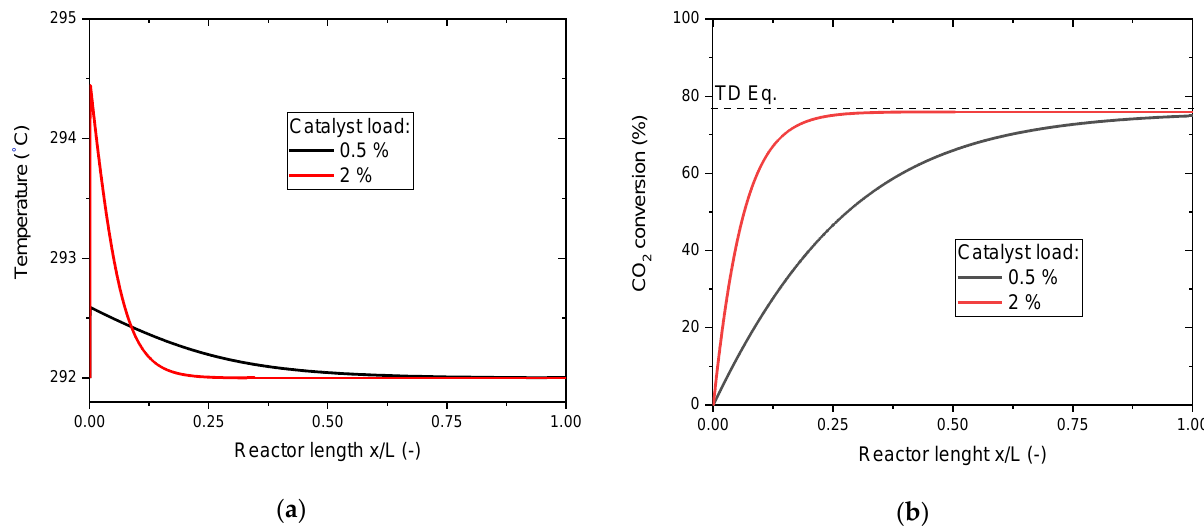
Figure 6. The predicted ( a ) temperature profile and ( b ) CO 2 conversion for the Sabatier reaction over a 0.5% (black line) and 2% (red line) Ru/Al 2 O 3 catalyst. For the 2% Ru/Al 2 O 3 catalyst, an important reaction hotspot (ca. 5.5 °C) is predicted.